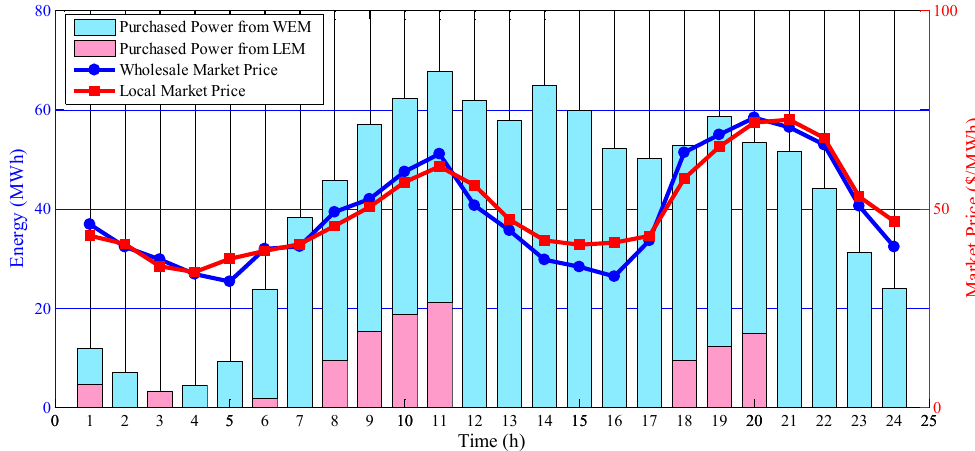
Figure 9. Distribution System Operator’s (DSO’s) traded energy with markets in the DA stage considering the competitive environment.